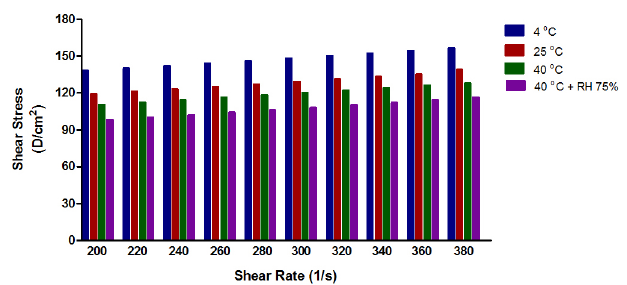
FIGURE 7 - Rheogram of HR Emulsion at different temperature after 2 months. Temperatures tested were 8 o C (blue bars), 25 o C (red bars), 40 o C (green bars), and 40 o C + 75% RH (violet bars).